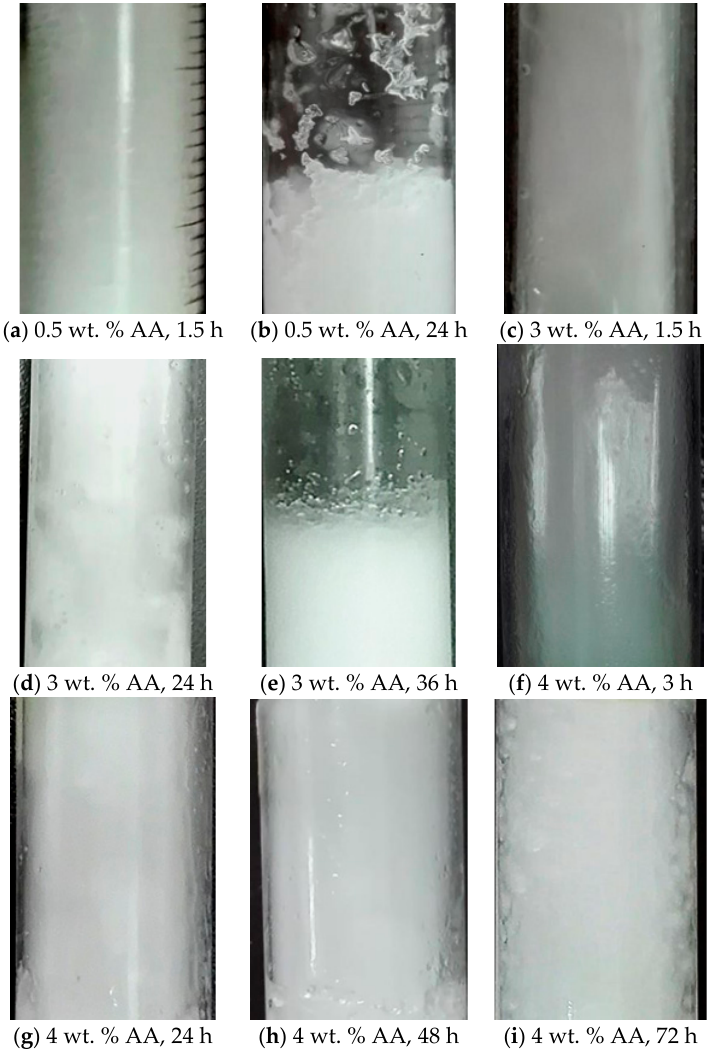
Figure 2. The photographs of TBAB hydrate with different amount of 90% cocamidopropyl dimethylamine +10% glycerol (AA) addition.